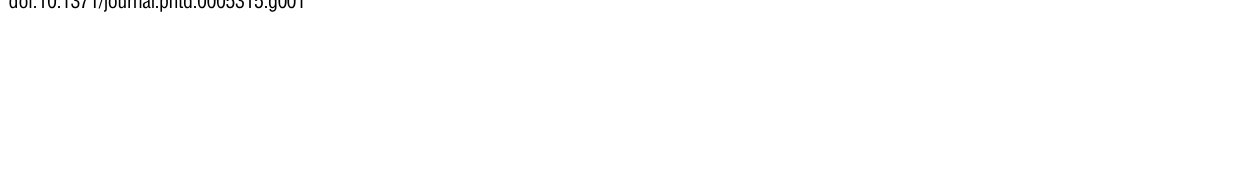
Fig 3. Multilocus tree of Rhinocladiella based on ITS and partial BT2 sequences. Constructed with maximum likelihoodimplemented in MEGA 7. Bootstrap values of > 80% from 100 resampled data sets are shown with branches. Cladophialophorayegresii and C. carrionii comprised the outgroup. Novel species causingchromoblastomycosis are indicatedwith red branches. Type strain in bold.